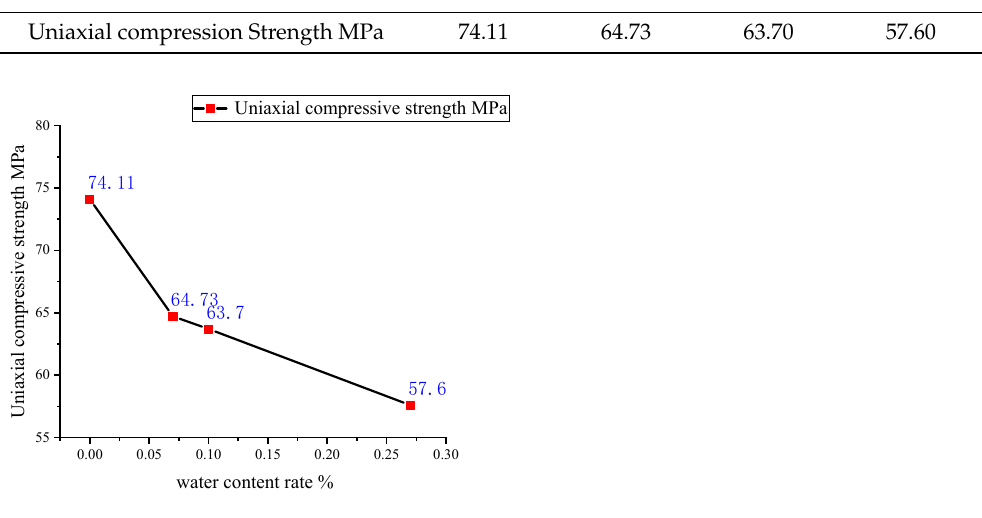
Figure 5. Uniaxial compressive strength of limestone samples with different water content rates .